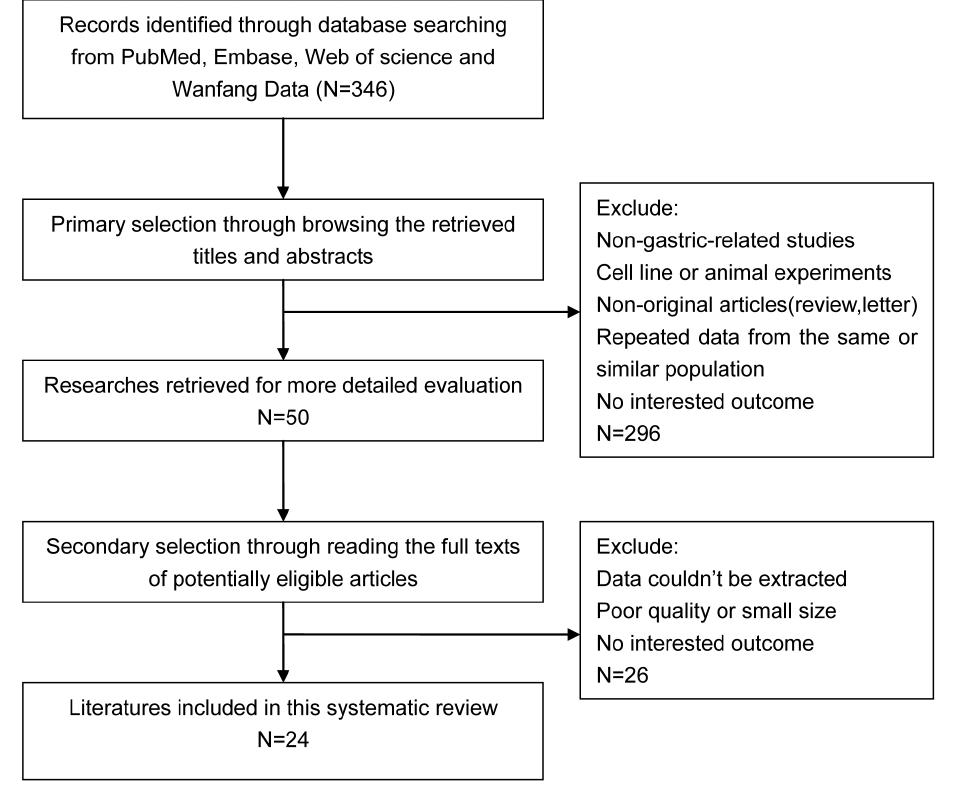
Figure 1. Flow diagram of study selection procedure.